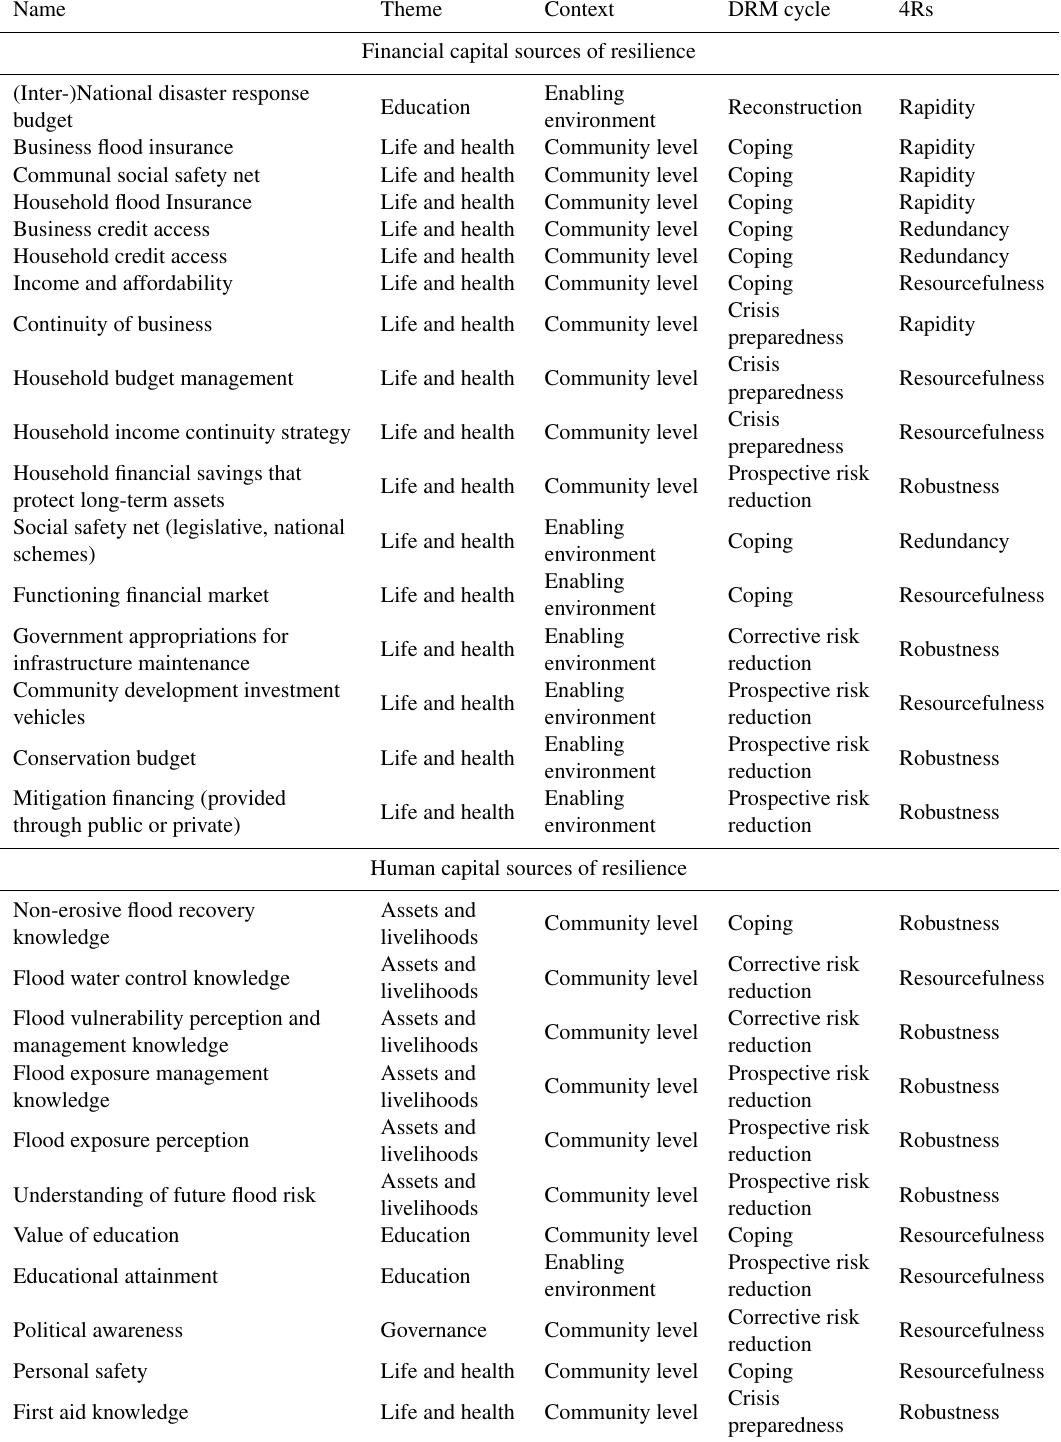
Table B1. The 88 sources of resilience grouped by capital, showing other categorization